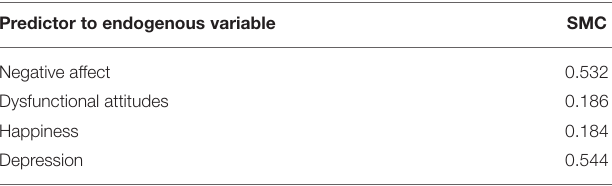
TABLE 4 | Squared multiple correlations (SMCs) for all the Endogenous variables in modified